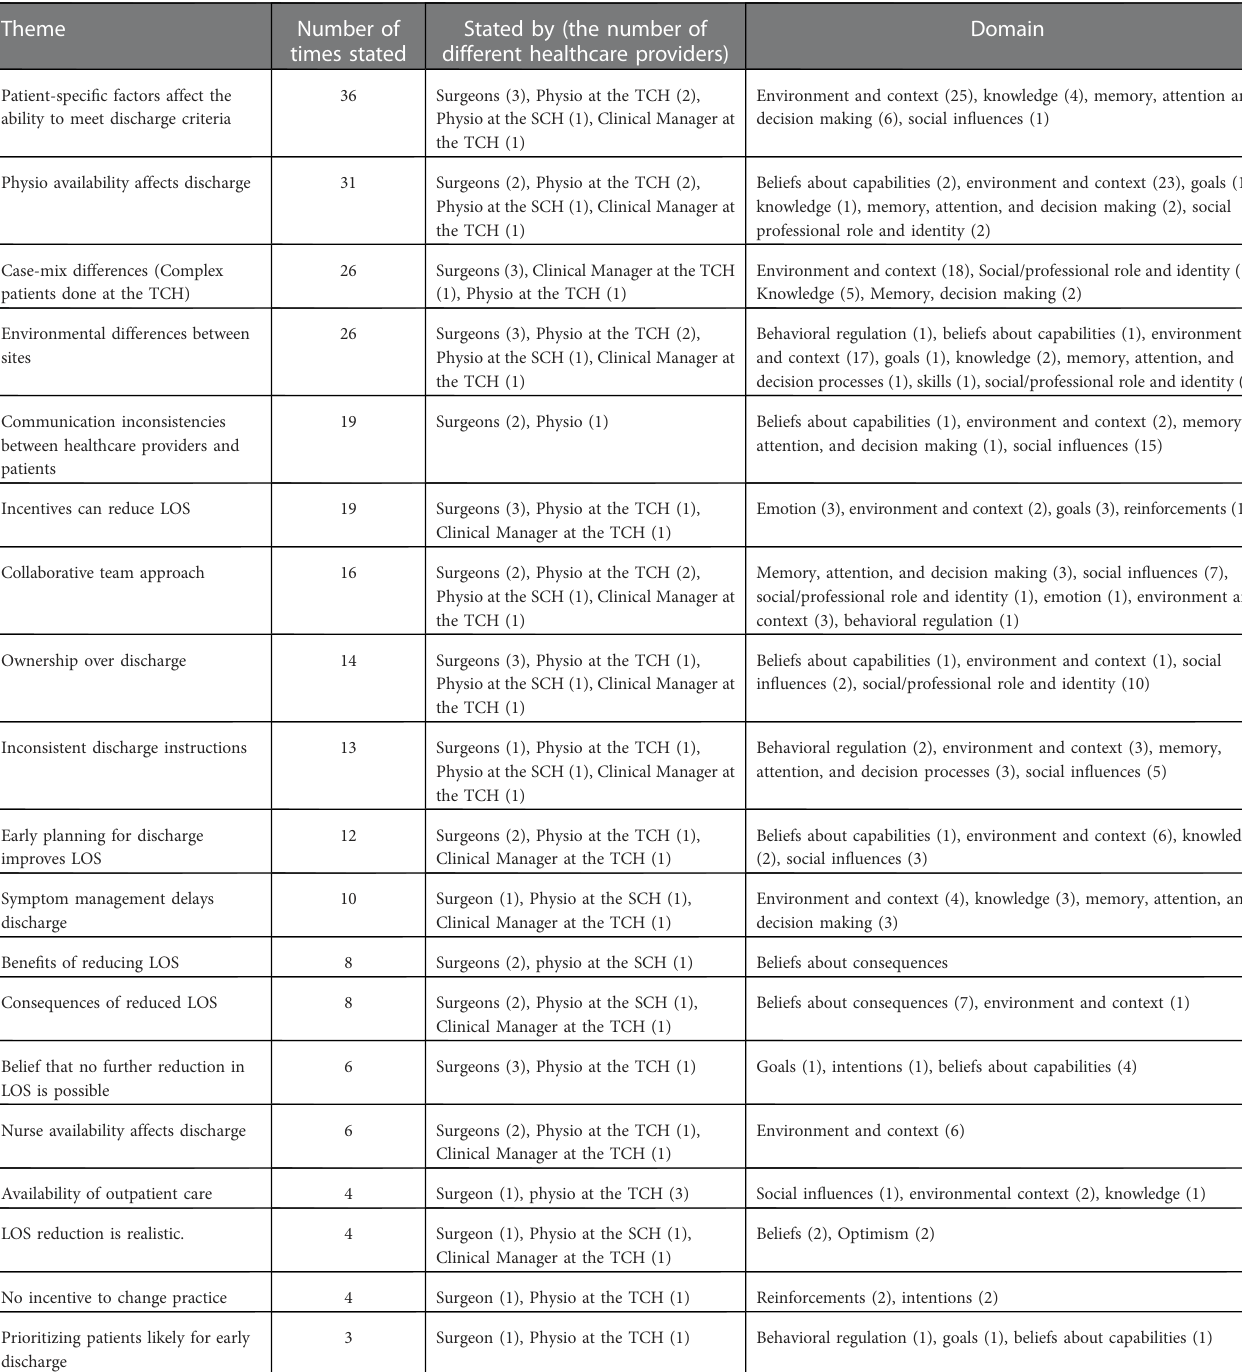
TABLE 3 List of the most salient themes identi fi ed through seven qualitative interviews (identi fi ed by at least two different interviewees). Theme Number of Stated by (the number of times stated different healthcare providers)